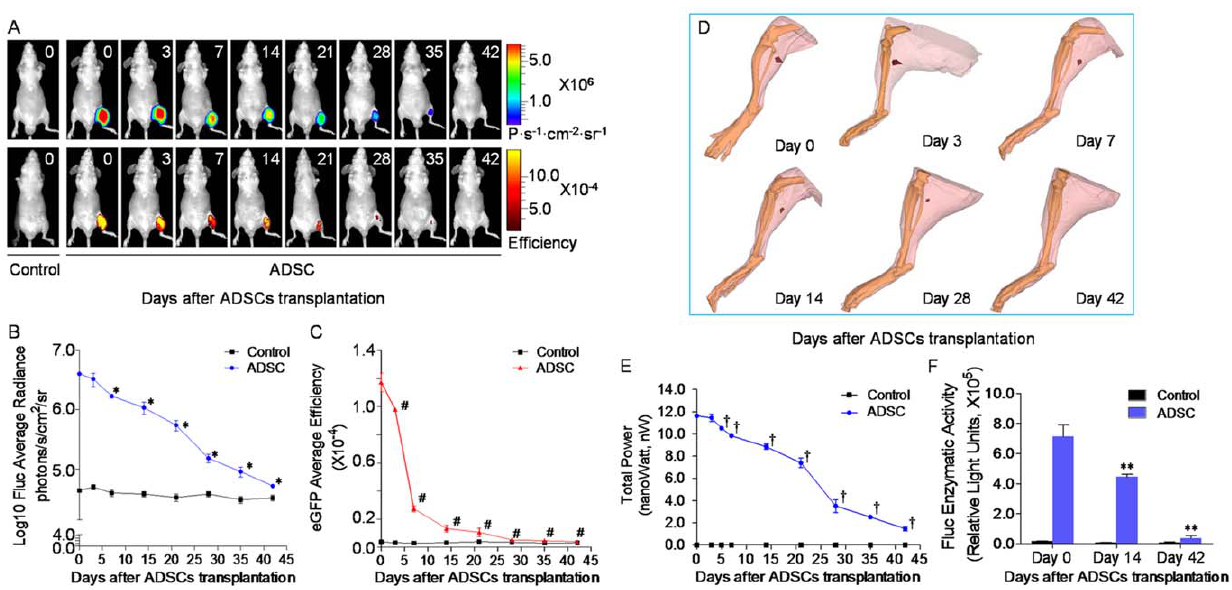
Figure 3. Longitudinal tracking of transplanted mADSCs Fluc + GFP + using multimodality imaging invivo . In vivo BLI/FRI/BLT/micro-CT tracked mADSC Fluc + GFP + survival in the ischemic hindlimb of the same representative animal. Progressive decay of bioluminescence ( a upper and b ) and fluorescence signal intensity ( a lower and c ) over time is indicative of donor mADSCs Fluc + GFP + death. Tomography and reconstruction of bioluminescence signals were performed by our BLT/micro-CT platform to show the in vivo kinetics of mADSCs Fluc + GFP + (red mass) in detailed 3D resolution ( d ). Reconstruction of bioluminescence total power (nanoWatts) also displayed a downward trend ( e ), confirmed by ex vivo Fluc assays ( f ). n=20 for each. Error bars: mean 6 SD. * P , 0.01 vs. day 0, # P , 0.001 vs. day 0, { P , 0.05 vs. day 0, ** P , 0.001 vs. day 0 (within ADSC group).